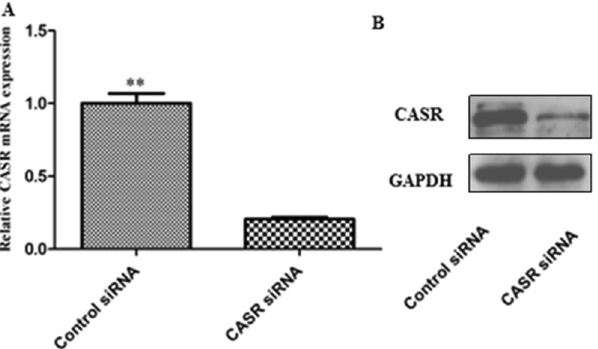
Figure 5. Validation of CASR knockdown. ( A ) CASR mRNA levels in bovine hepatocytes transfected with control or CASR siRNA. ( B ) A representative western blot of CASR protein in bovine hepatocytes transfected with control or CASR siRNA. Values are presented as the means ± S.E.M. “ ** ”Represents significant differences P < 0.01.